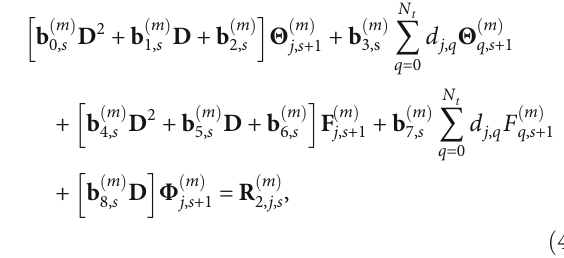
: 8, ξ = 1, N N Df = Sr = Bi = 0 : 5, He b = t = w = 0